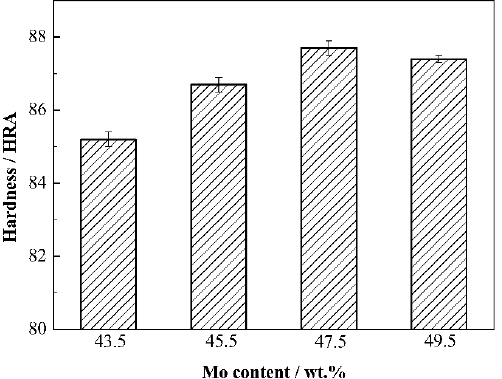
Figure 9. Hardness of Mo 2 FeB 2 based cermets with different Mo